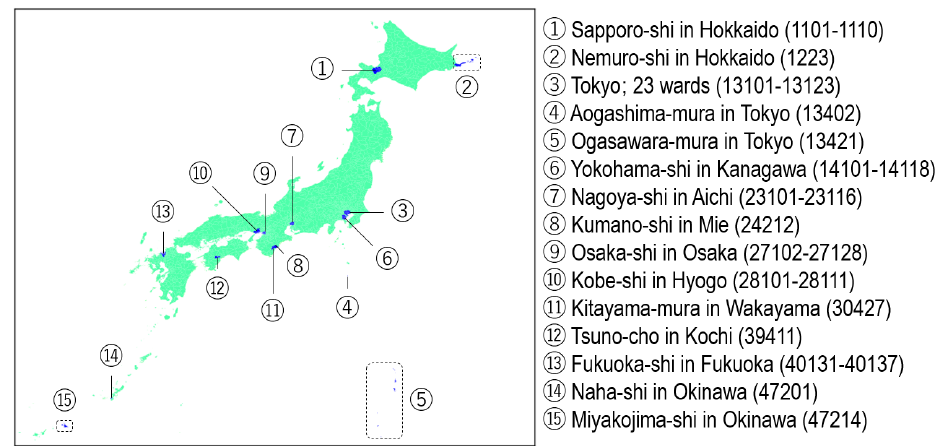
Figure 7. Location of the Japanese municipalities focused on in this study. The municipal number is shown in parenthesis.